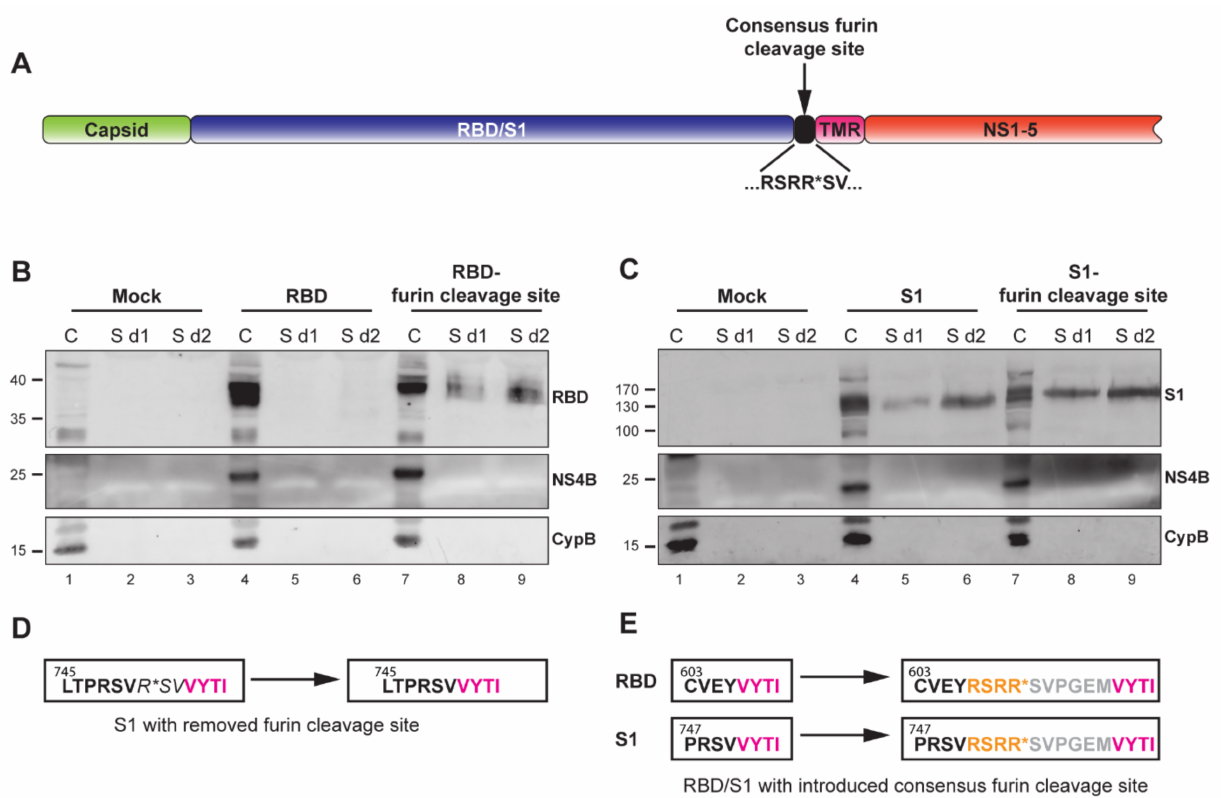
Figure 3. Characterization of MERS-CoV spike RBD- or S1-expressing replicons containing a furin cleavage site at the C-terminus of the insert. ( A ) Schematic representation of the YF-replicons with a consensus furin cleavage site, inserted at the C-terminus of the foreign domain RBD/S1 and upstream of the TMR. Successful furin cleavage results in the release of the RBD/S1 domain from the TMR and secretion in the medium. ( B , C ) Western blot analysis of cell lysates and supernatants of cells containing RBD- or S1-YF-replicons with or without engineered furin cleavage sites. Cell lysates were harvested at 1 day postelectroporation and are indicated by the “C” lanes. Supernatants were harvested 1 or 2 days postelectroporation and are indicated as “S d1” and “S d2”, respectively. The quantities of the cell lysates loaded on gel were normalized for the percentage of replicon-positive cells, as determined by flow cytometry (data not shown). The quantity of the supernatants was normalized to correspond to the amount of the loaded cells. The detected proteins are indicated on the right of the Western blot images. NS4B is a yellow fever virus protein and demonstrates the level of expression of the replicons. Intracellular chaperon cyclophilin B (CypB) was used as an internal control. ( D ) Amino acid sequence of the authentic C-terminal part of MERS-CoV S1 with its furin cleavage site (left box) and with the deletion of the furin cleavage site in the YF replicon (right box). ( E ) Amino acid sequence of the C-terminus of the RBD (upper left box, black letters) or S1 domains (lower left box, black letters) and the start of the downstream TMR (left boxes, pink letters) in the YF-replicons without furin cleavage sites and with introduced consensus furin cleavage sites (right boxes, yellow letters). The grey letters show the N-terminal 6 amino acids of the S2 domain of MERS-CoV spike used as a short spacer between the furin cleavage site and the downstream TMR. ( D , E ) Numbers illustrate amino acid position in the spike